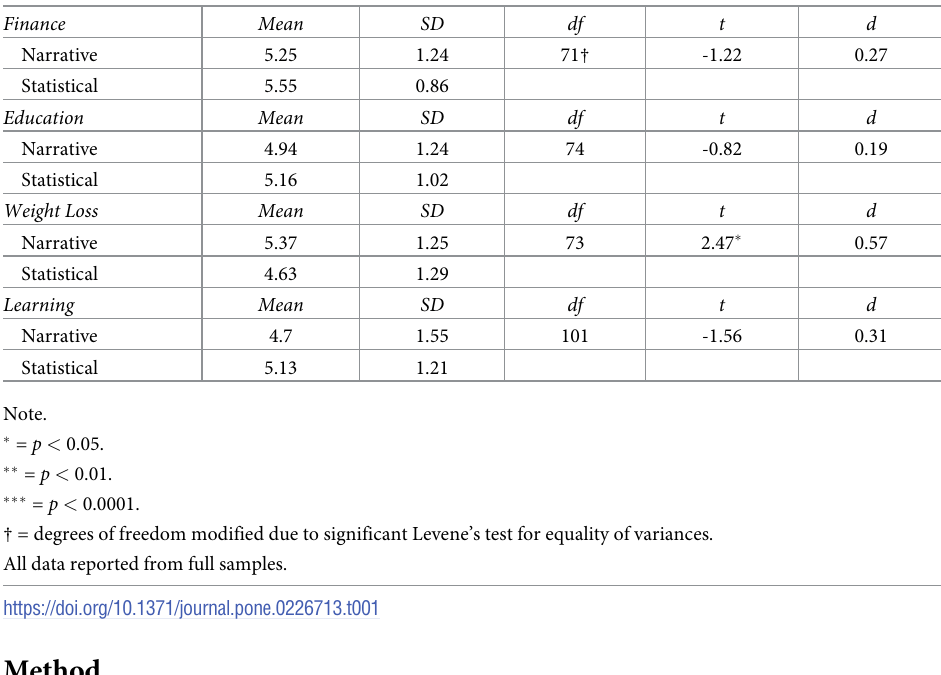
Participants. Undergraduates (N = 235) participated for partial course credit. The sample was majority female (66%) and white (70%). Ages ranged from 18 to 24 ( M = 19.07, SD = 1.14). For this study, the key effect is a two-way interaction between message type and personality dimension. We identified the smallest effect size we could reliably detect (80% power) with